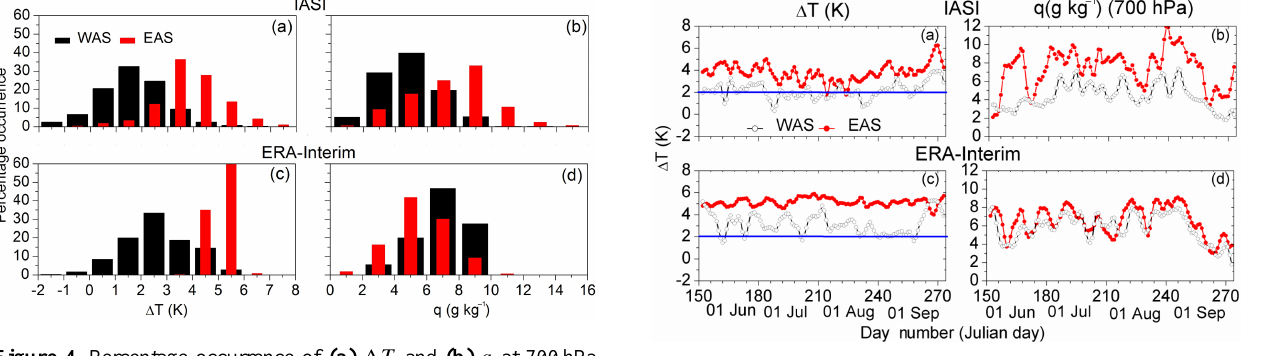
Figure 5. Time series of (a) (cid:49)T and (b) q at 700hPa observed over WAS and EAS grid boxes during the monsoon season of the year 2012 by IASI. Panels (c) and (d) are the same as panels (a) and (b) but obtained using ERA-Interim data. Three-point smoothed curves are